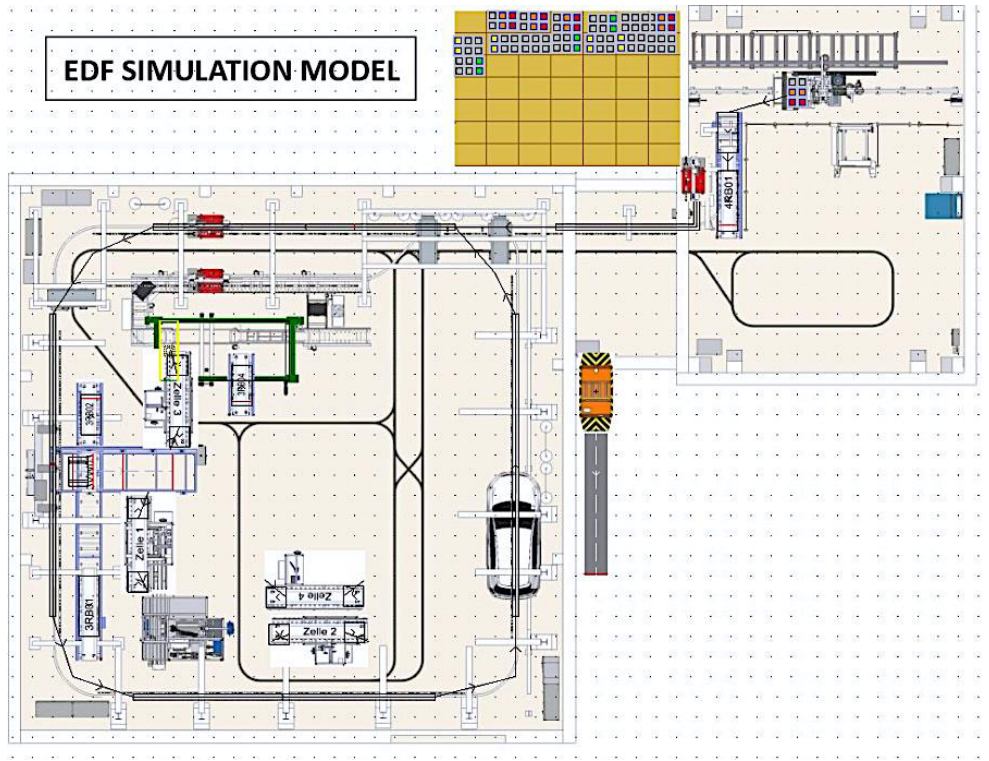
Figure 6. EDF simulation model.